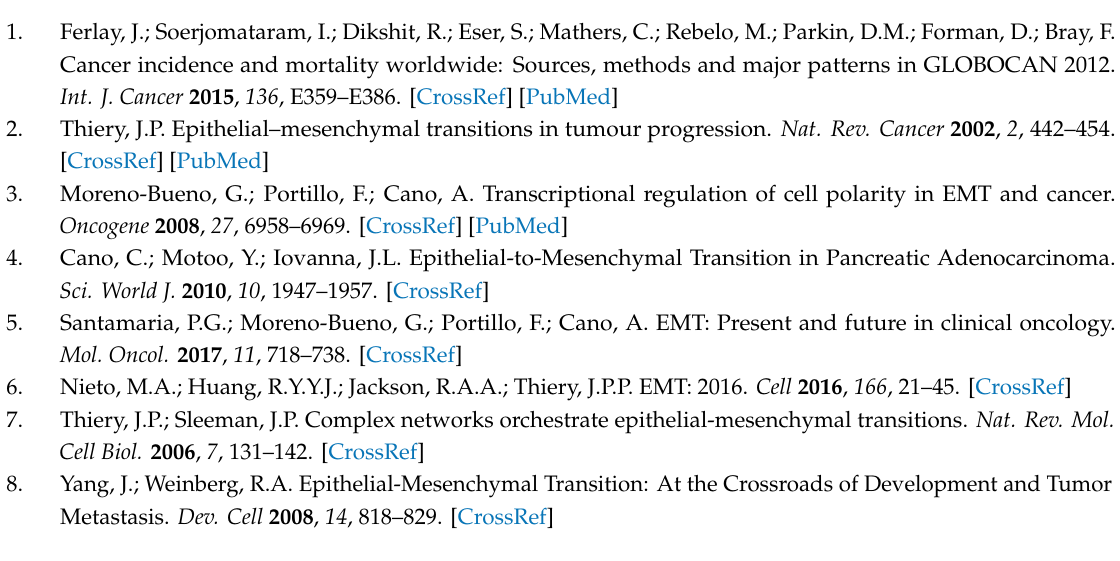
Table S1: List of antibodies used for immunocytochemistry and western immunoblotting; Table S2: List of primers used for real-time PCR; Figure S1B: Original representative full-length blots of Figure 1B showing Snail protein detection and densitometry plots. Recombinant human Snail (positive control) was added in excess to be more visible; Figure S1C: Original full-length blots of Figure 1C and densitometry plots; Figure S2B: Original full-length blots of Figure 2B showing MMP-14 expression. The wild-type MC38 cells’ track was cropped in Figure 2B since it was similar to that of Mock-MC38 cells; Figure S4B: Original full-length blots of Figure 4B showing GPC1 expression. Each of them were taken into account while densitometry analysis was performed; Figure S3: Amount of EVs released by Mock and Snail-overexpressing MC38 clones shown as µ g of protein in EV lysates obtained from 10 × 10 6